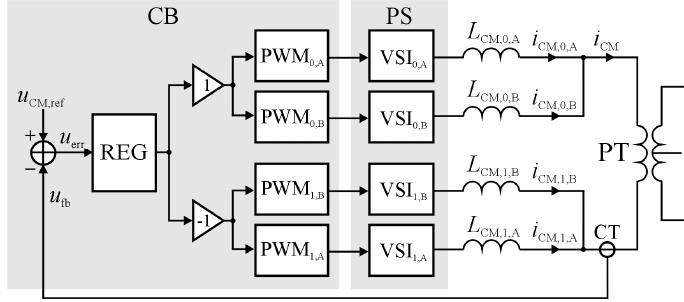
Figure 8. Block scheme of the CM based on dual-channel converter (CCN).